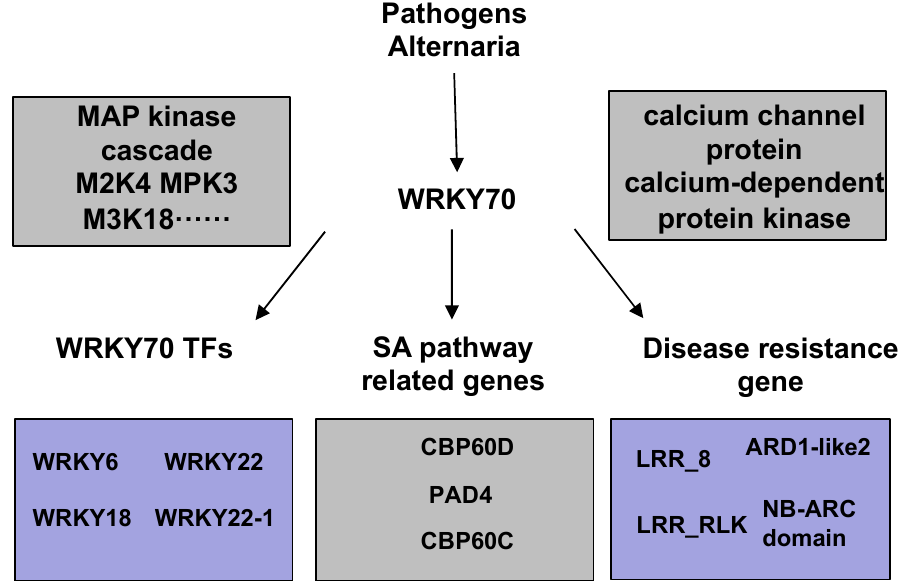
Figure 8. A proposed model of the PsnWRKY70 -mediated regulatory network response to Alternaria infection in Populus . PsnWRKY70 indirectly activated PTI pathway genes, including MAP kinase cascades, calcium channel proteins, calcium-dependent protein kinases, and SA pathway-related genes. It directly binds to the promoters of homologous genes and induces the expression of PsnWRKY6 , PsnWRKY18 , PsnWRKY22 , PsnWRKY22-1 , and R genes in the ETI pathway. The gray represents that PsnWRKY70 indirectly regulates genes. The purple represents that PsnWRKY70 directly regulates genes.